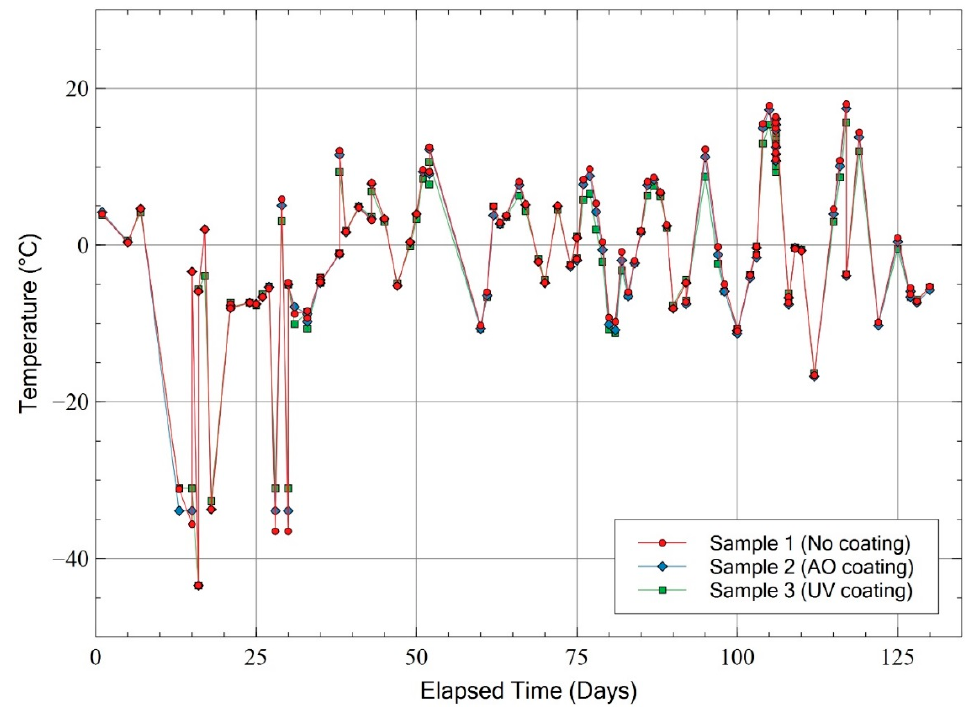
Figure 11. Variation of temperature measurement for each sample against time. The temperature varied between − 40 and 20 ◦ C in orbit.